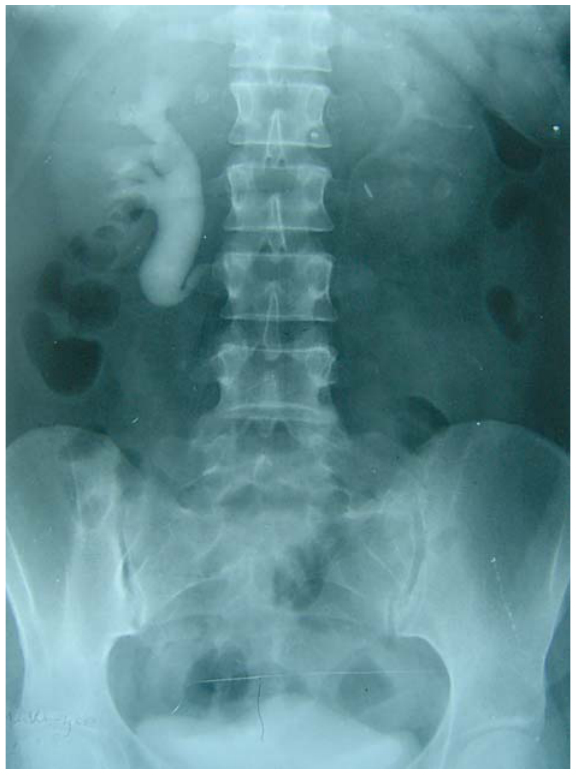
Figure 1 – Pre-operative IVU.